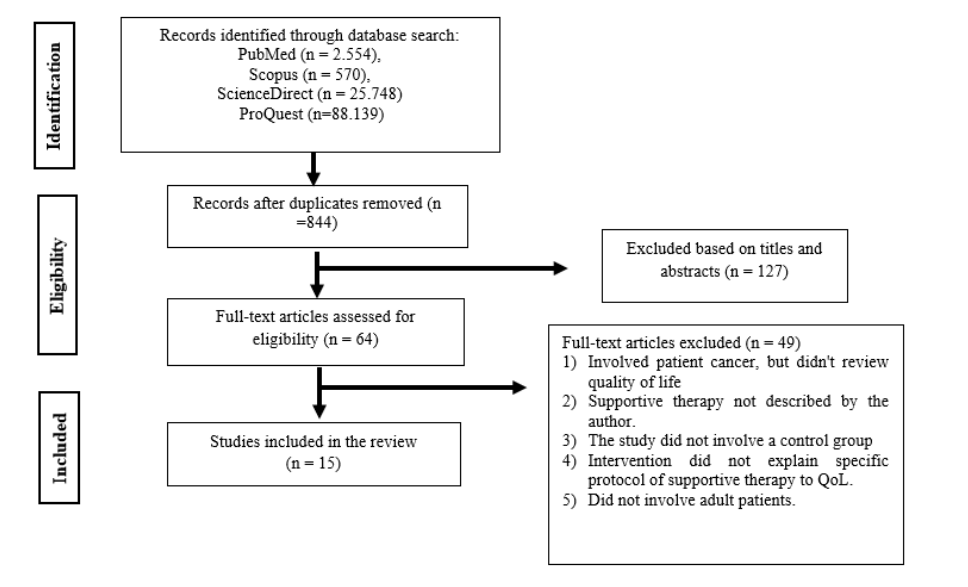
Figure 1. PRISMA flowchart showing included and excluded